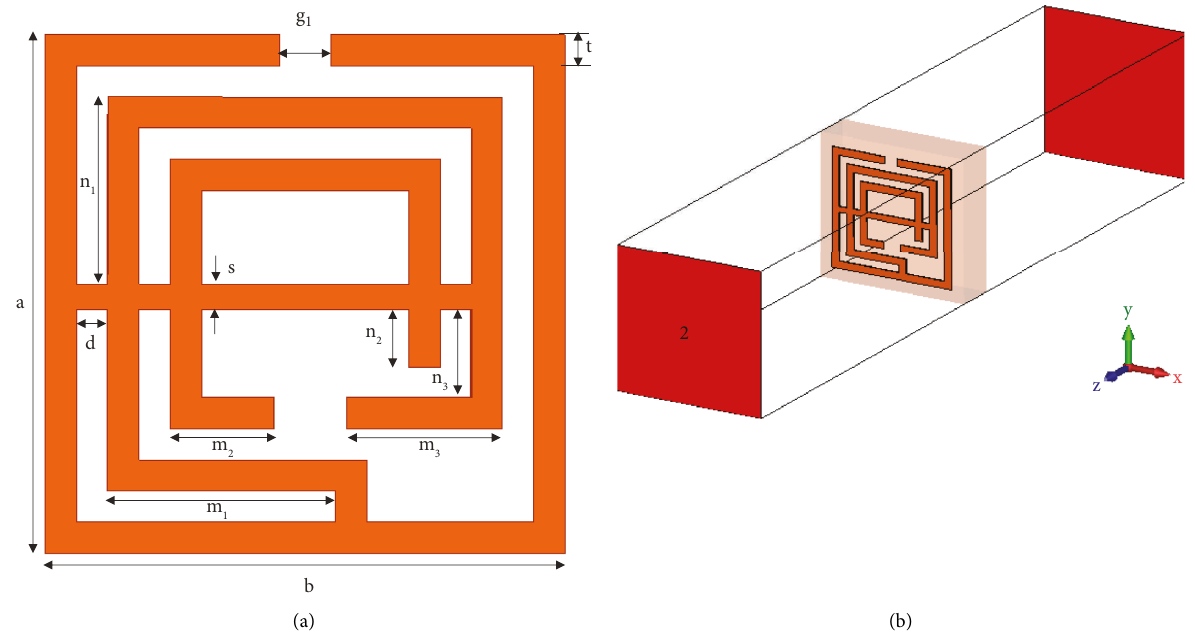
Figure 1: The MTM unit cell structure (a) schematic layout and (b) CST simulation